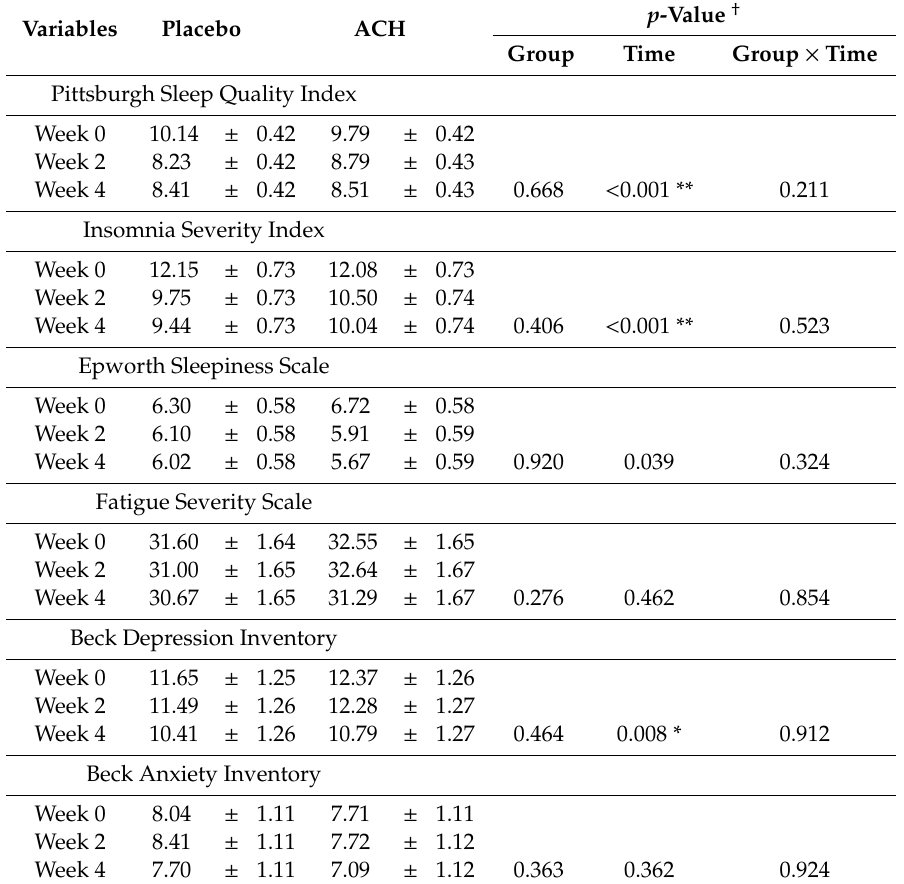
Table 2. Di ff erences in sleep disturbance symptoms, daytime functioning, and psychiatric aspects between control (placebo) and test (alpha-s1 casein hydrolysate (ACH))